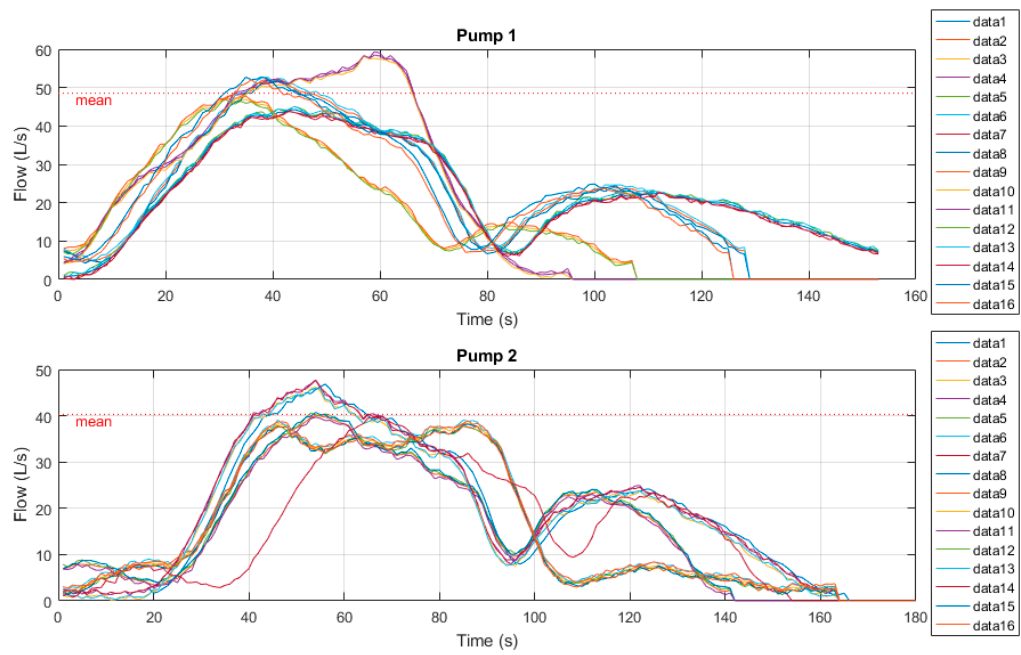
Figure 15. Site C time series radar plots.